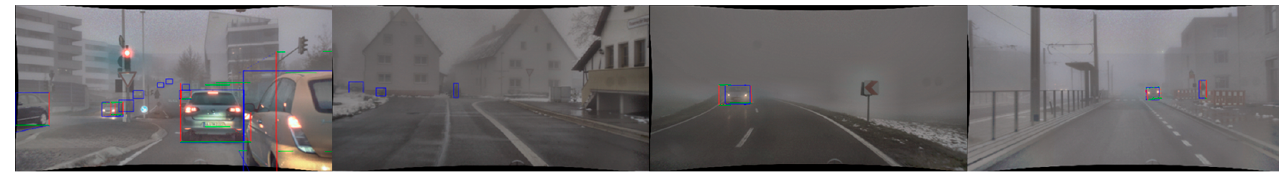
Figure 16. Ground truth of object detection.